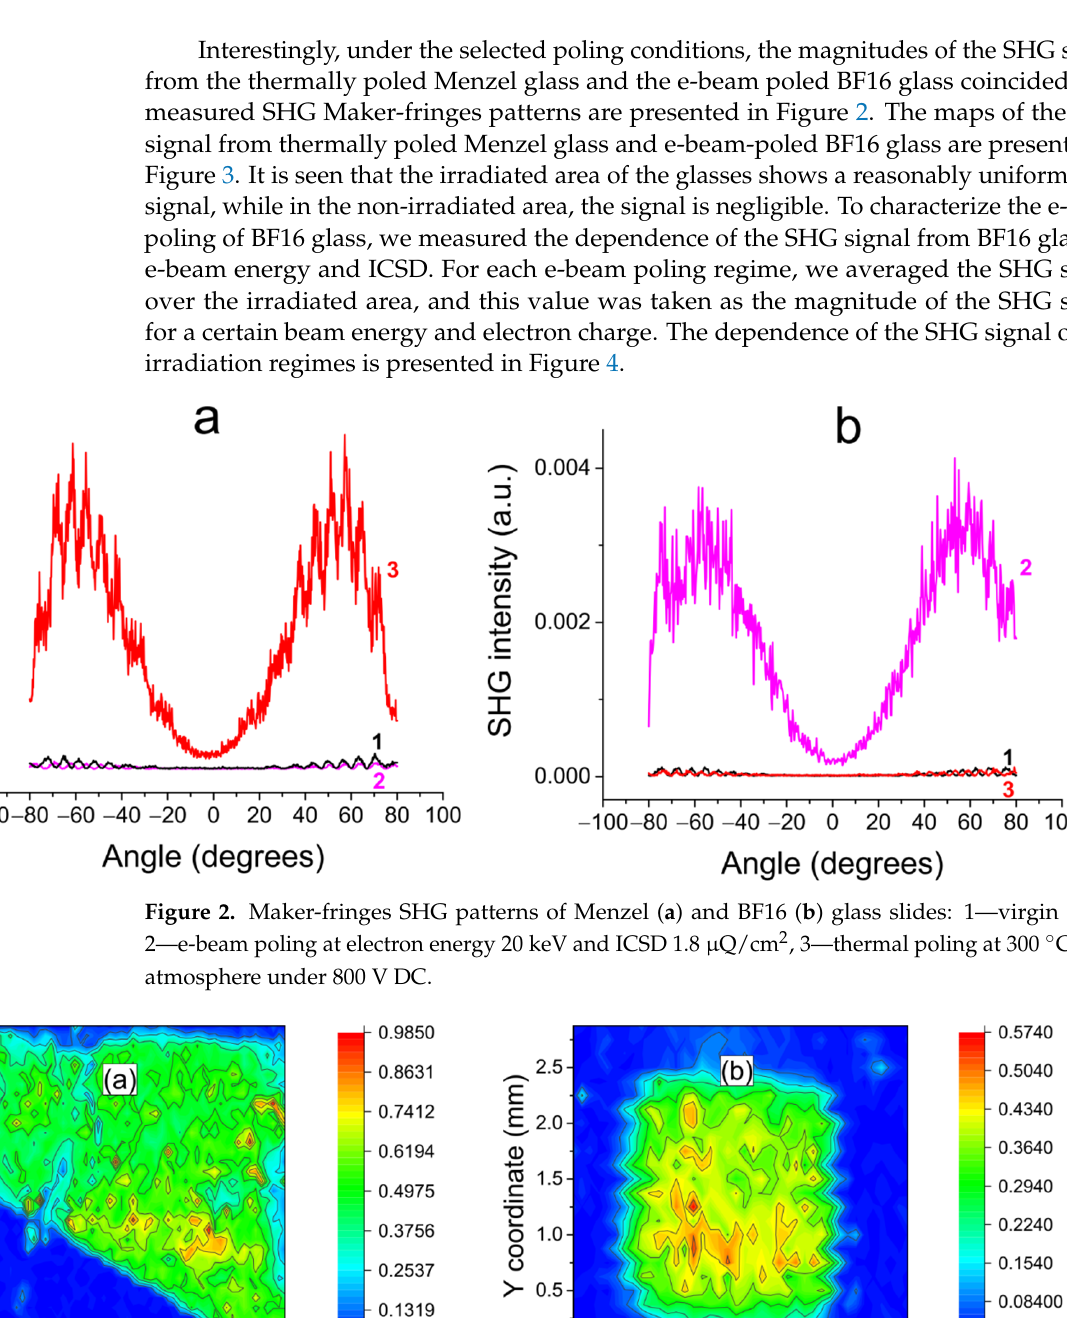
Table 2. SHG signal from Menzel and BF16 glass slides poled under selected conditions.